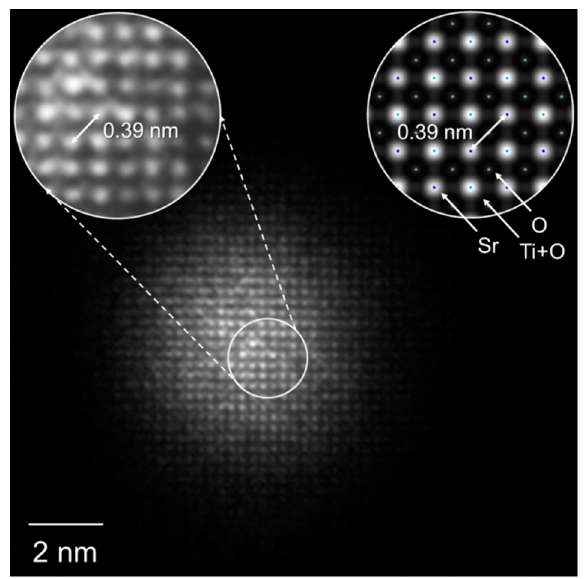
Figure 1. High resolution transmission electron microscopy (HRTEM) image of a nano-region of a SrTiO 3 extended sample in [100] zone axis, with a zoom in the inset on the left. A simulation for underfocus 41.3 nm and specimen thickness of 25.0 nm is shown in the inset on the right. The dots in the simulation point to the structural positions of the SrTiO 3 atomic species in this projection: Sr = Blue, Ti+O = pale blue, O = pale green.